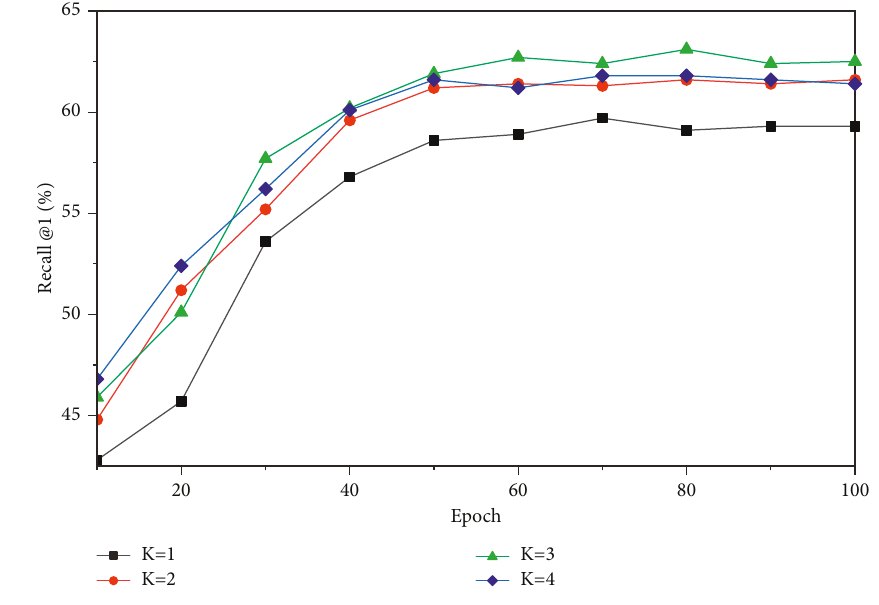
Figure 6: Performance with different numbers of K